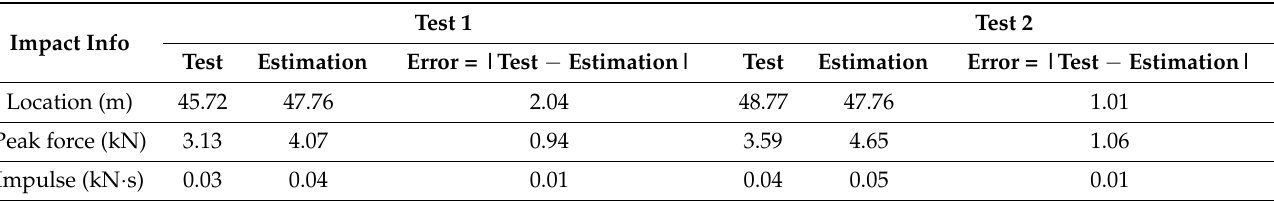
Table 5. Comparison of bridge impact monitoring systems.